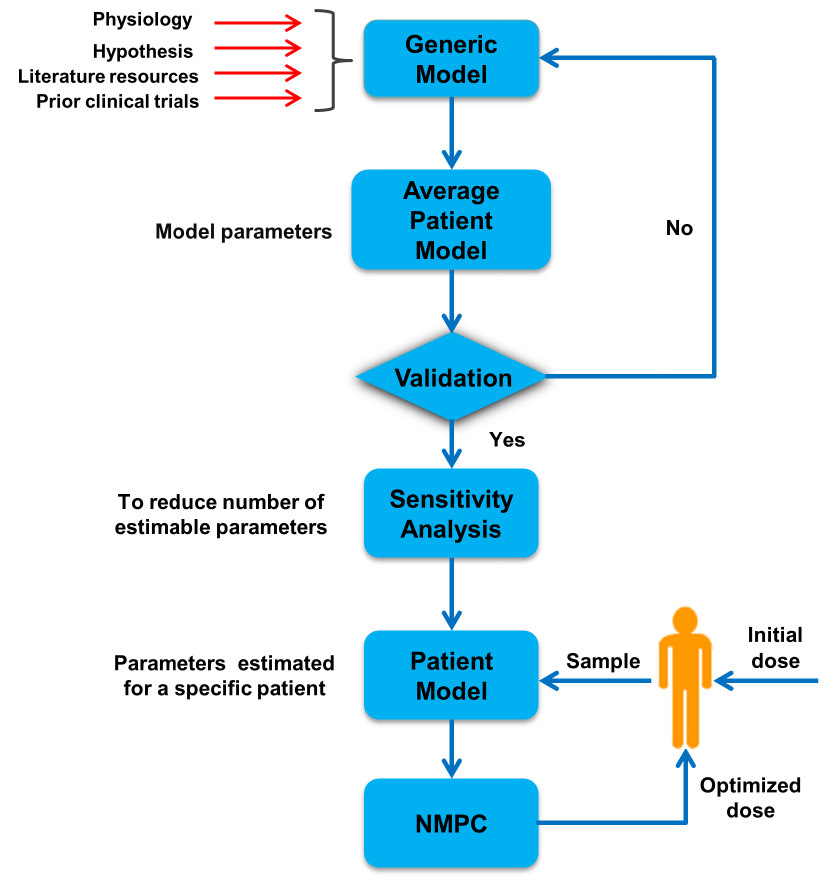
Figure 1. A generalized approach for model-based prediction and optimization of treatment outcome. A model representing the underlying physiology is formulated and average patient parameters are estimated using data from literature and past clinical trials. GSA is used to reduce the parameter space and identify most sensitive parameters with sparse clinical data. Following nominal initial dose, few measurements are taken from an individual patient in order to adapt the model to the patient. Patient-specific model is used to predict the treatment outcome and subsequent doses are optimized based on NMPC prediction.